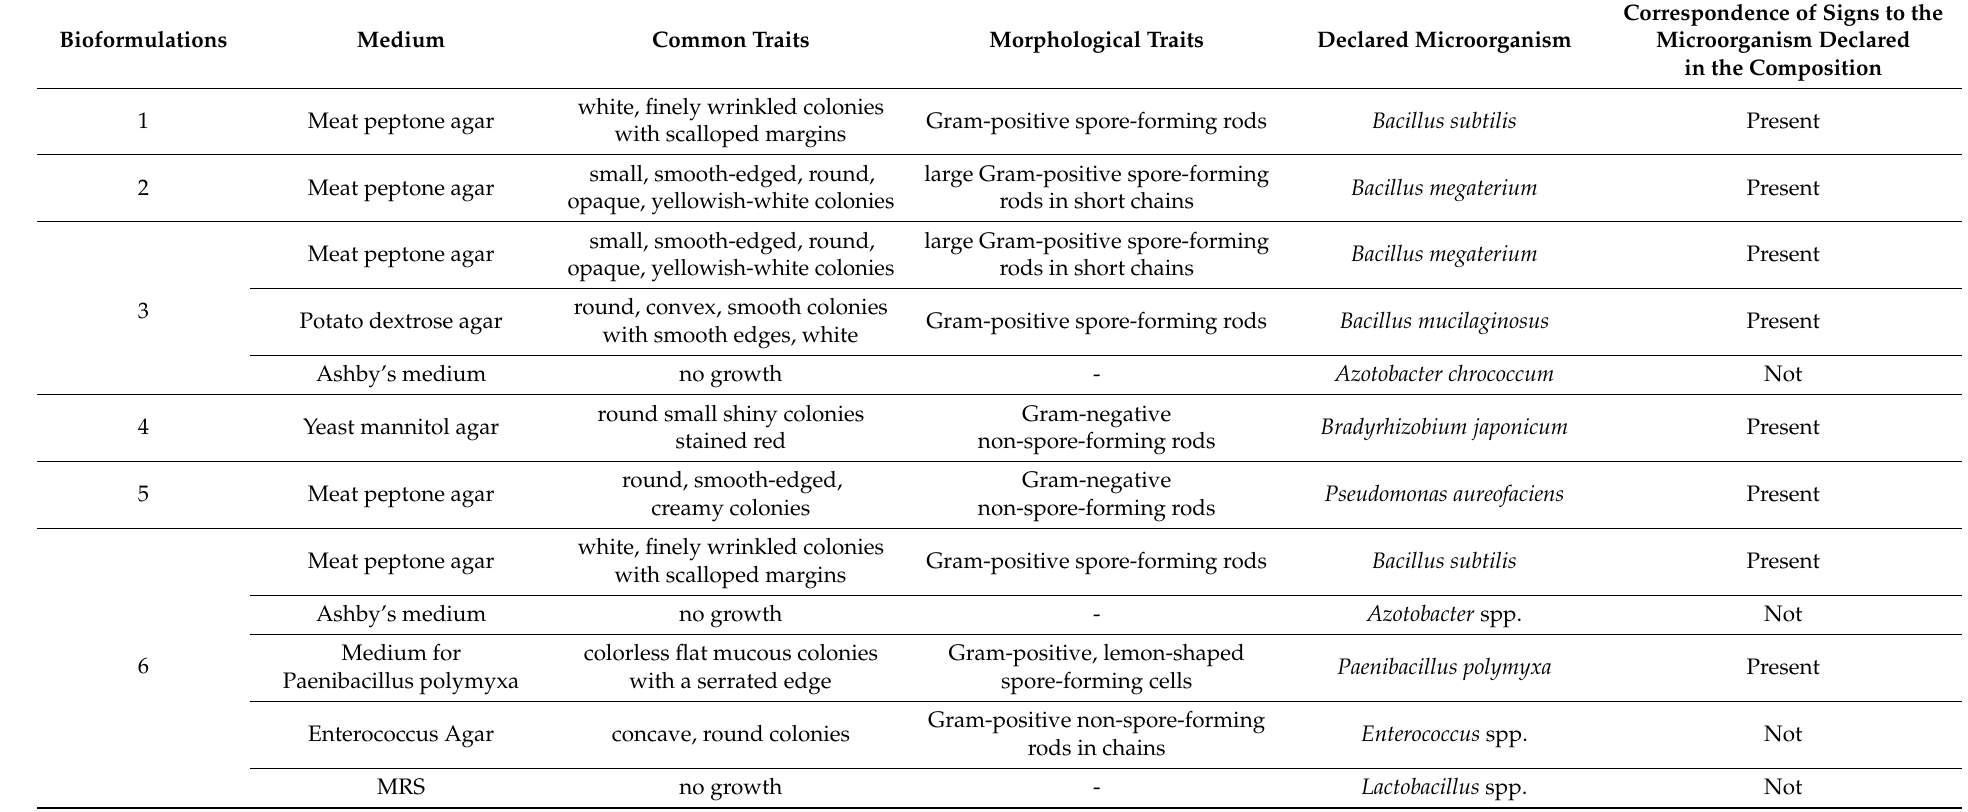
Table 1. Results of microbiological examination of